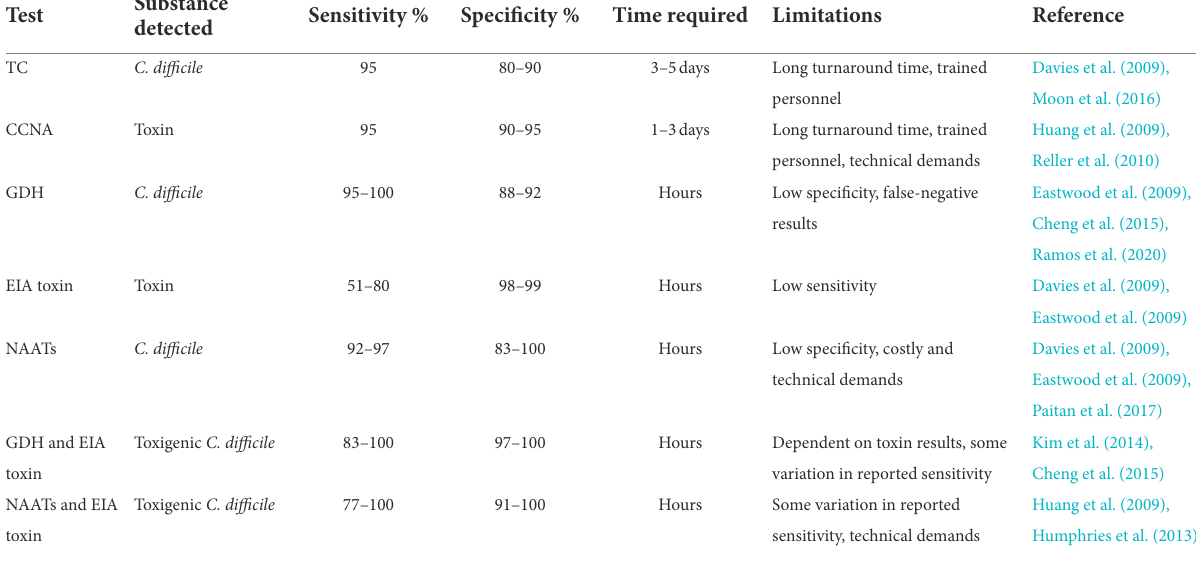
TABLE 1 Summary of diagnostic tests for Clostridioides defficile